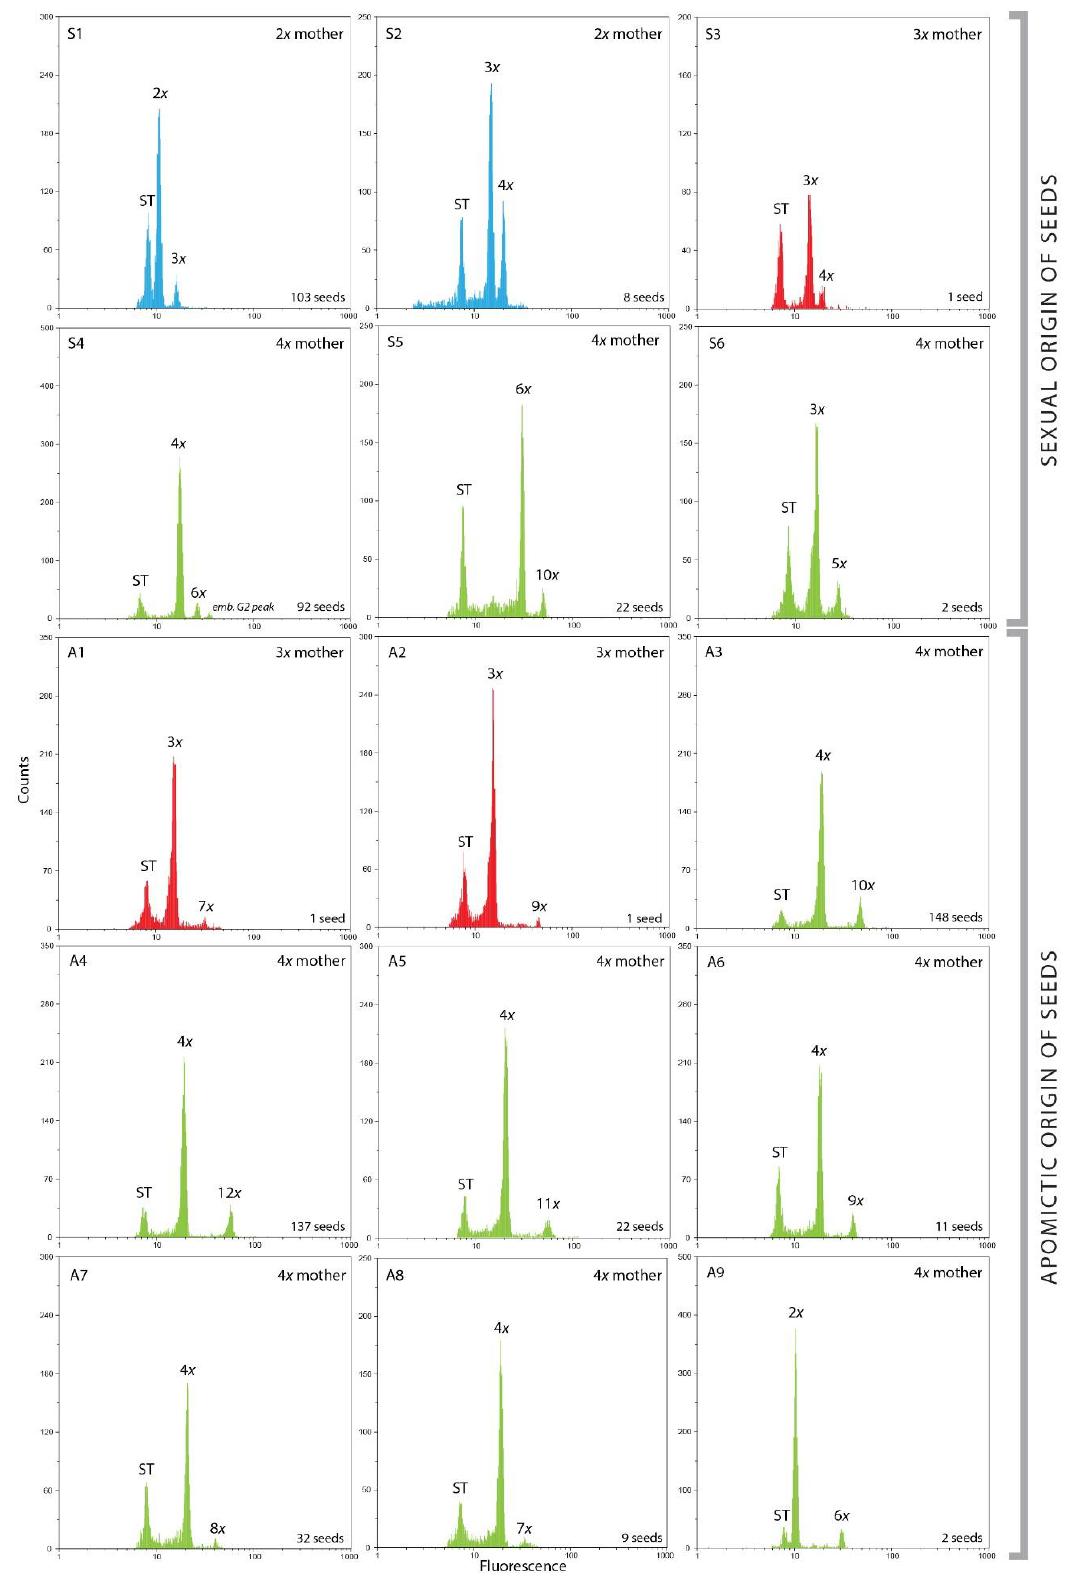
Figure 2. Flow cytometric histograms (log abscissa) of Cotoneaster integerrimus seed formation from sexual ( S1 – S6 ) or asexual ( A1 – A9 ) origin. The first fluorescence peaks correspond to the internal standard (ST, Oryza sativa L. ssp. japonica ‘Nipponbare’), the second ones to the embryo, and the third ones to the endosperm (blue: 2x mother, red: 3x mother, green: 4x mother).